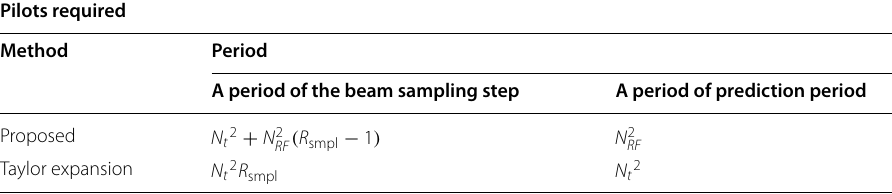
Table 1 Pilot cost comparison Pilots